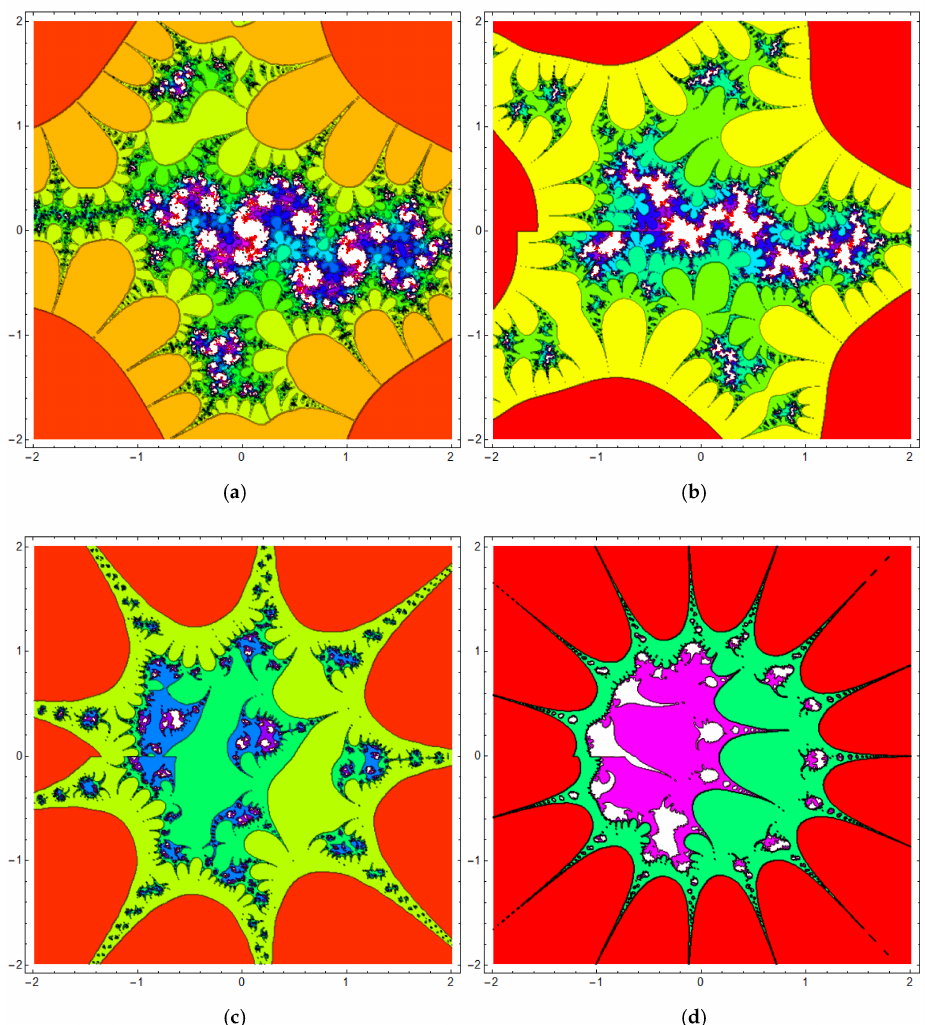
Figure 7. The Julia sets generated by the generalized fractional cosine map at α = 1 and q = 0.5 + 0.52 i , where ( a ) p = 2, ( b ) p = 2.5, ( c ) p = 4.3, and ( d ) p =